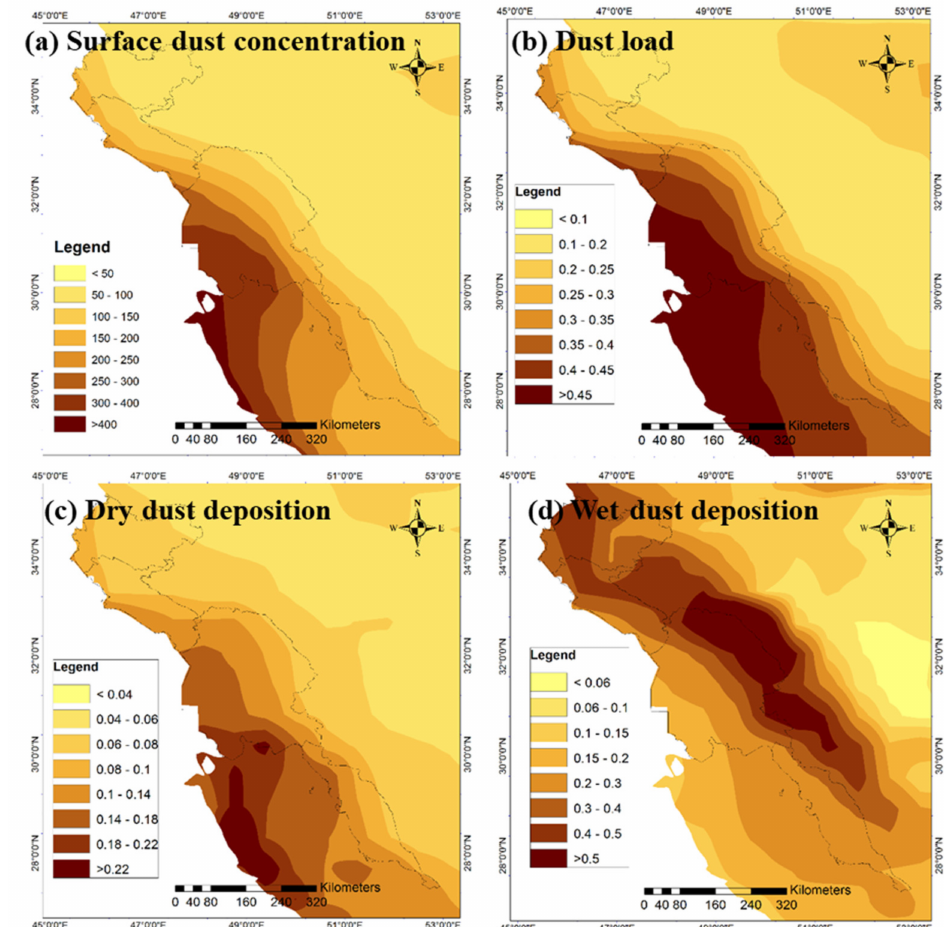
Figure 8. Spatial distribution of the mean surface dust concentration (in µ g m − 3 ) ( a ), dust load (in g m − 2 ) ( b ), dry deposition (in µ g m − 2 s − 1 ) ( c ) and wet deposition (in µ g m − 2 s − 1 ) ( d ) from MERRA-2 retrievals during 1997–2018 over southwest